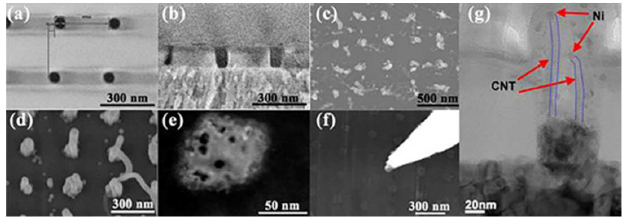
Figure 6. Scanning electron microscope (SEM) images of CNT vias. ( a ) Top-view image after patterning; ( b ) cross-section image after etching; ( c ) image of CNT vias; ( d ) image of CNT vias after dielectric filling; ( e ) top-view of a single CNT after ion milling; ( f ) nanoprobe landing on single CNT and making contact with CNT tips; ( g ) image of a 60 nm CNT via before ion milling, where red arrows indicate Ni catalyst particle at CNT tip and blue lines indicate the CNT sidewalls. Reprinted with permission from ref. [9]. Copyright 2015, IEEE.